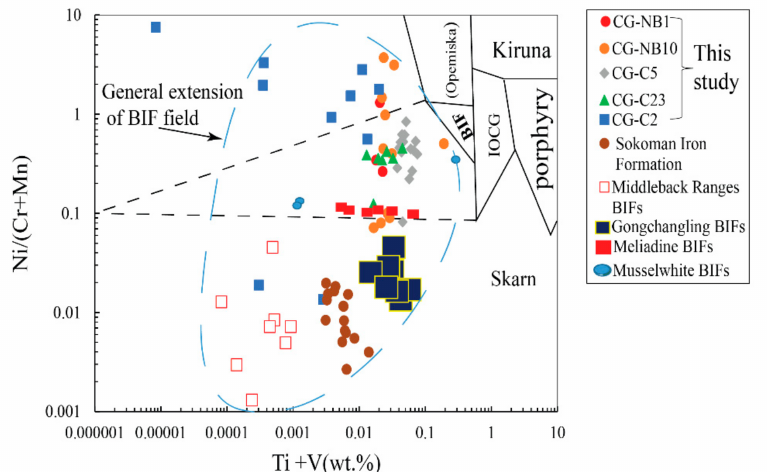
Figure 14. (Ti + V) vs. Ni/(Cr + Mn) discrimination diagram [64] for the Nabeba BIF magnetite. Magnetite from different types of iron deposits, including Kiruna apatite-magnetite, iron-oxide- copper-gold (IOCG), porphyry Cu, magmatic Fe-Ti-V oxide, BIF, and Opemiska-type, are also shown for comparison. The extended BIF field represented by a dashed black lines results from Gourcerol et al. [30]. The general BIF field represented by a dashed blue circle is generated from this study following the magnetite concentrations plots of from this study and Milddleback Ranges BIFs [33], Meliadine BIFs, Musselwhite BIFs [30], Gongchangling BIFs [32], and Sokoman iron formation [28,65].